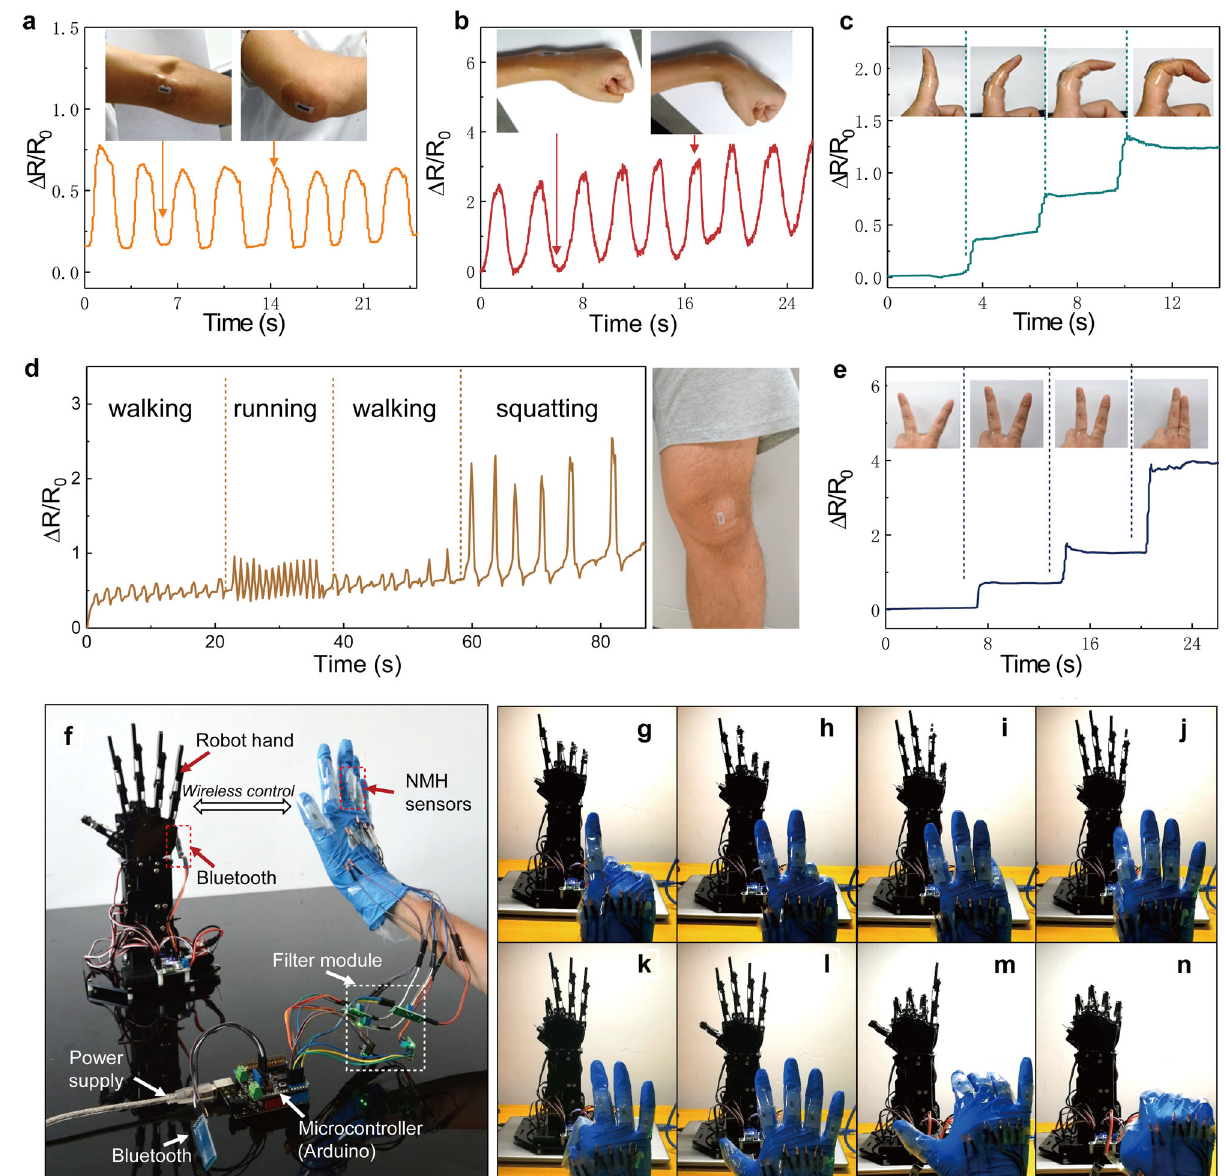
Fig. 6 Using the NMH strain sensor for human motion detection. a – e The relative change in the resistance of our strain sensor mounted on different locations of the human body: a elbow and b wrist bending. c Bending process of a fi nger. d Walking, running, and squatting of a knee joint. e Closing process of the fi ngers. f An interactive electronic system using a multichannel data-glove with fi ve NMH sensors to control a robotic hand by wireless communication. g – n Control of different numbers of fi ngers of the robotic hand by a human hand wearing the data-glove with NMH